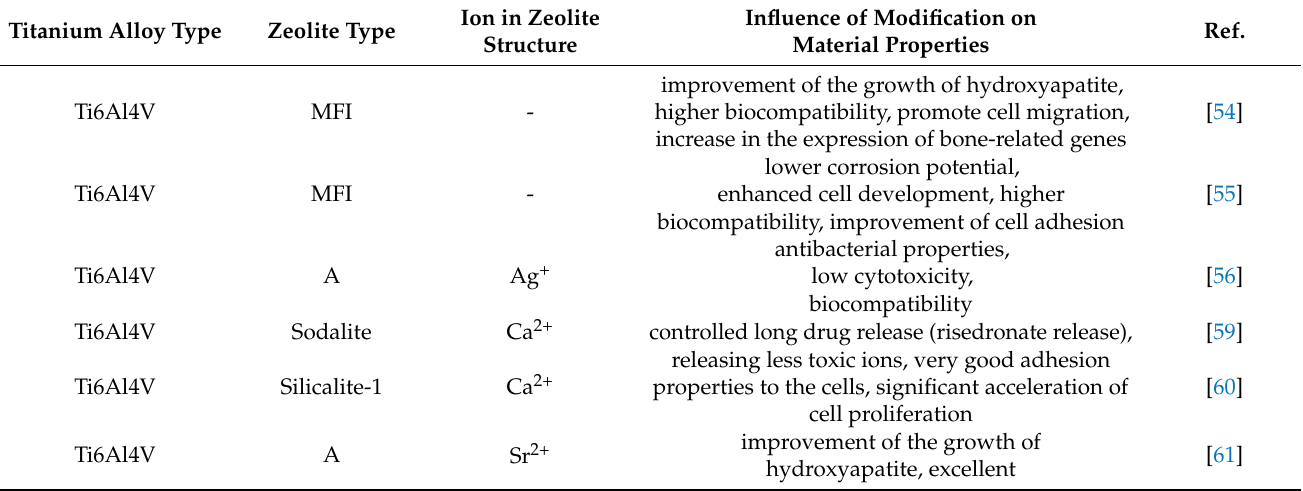
Table 1. The influence of zeolite layers on the properties of titanium alloys described so far in the